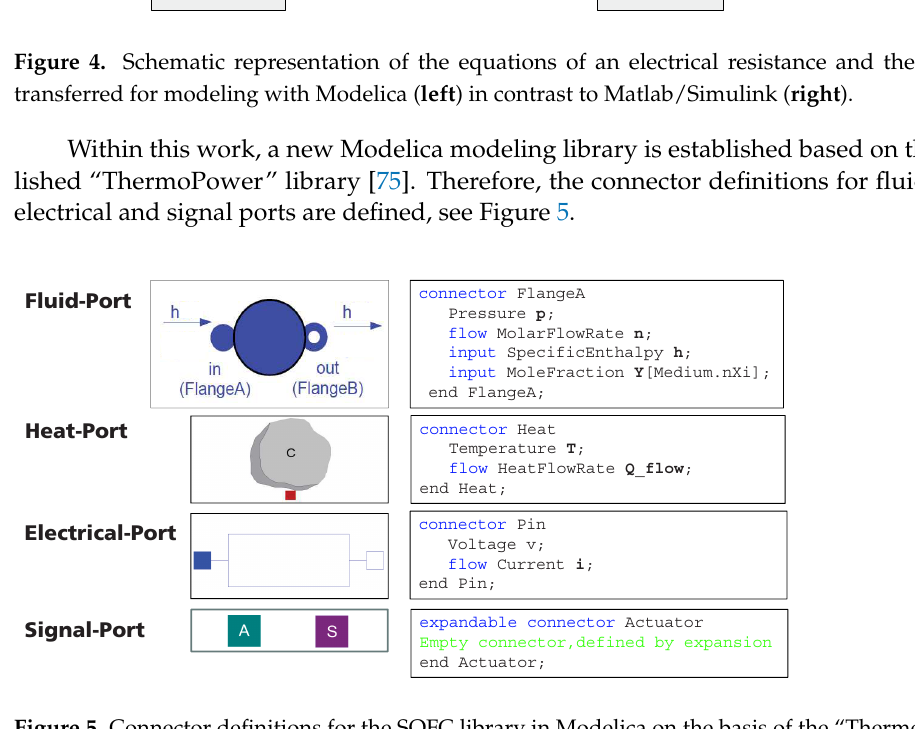
Figure 5. Connector definitions for the SOFC library in Modelica on the basis of the “ThermoPower” library